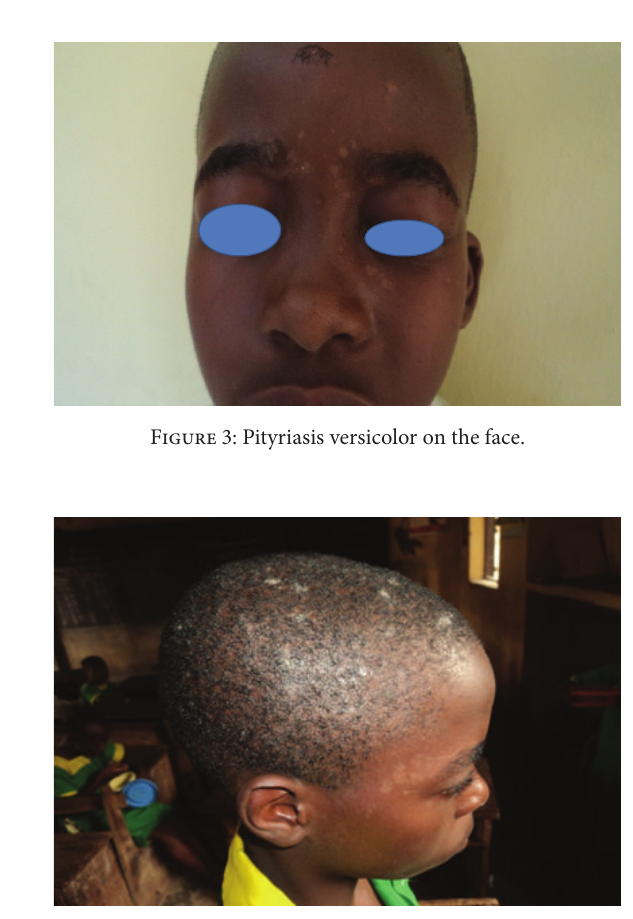
Figure 4: Tinea capitis and pityriasis versicolor.